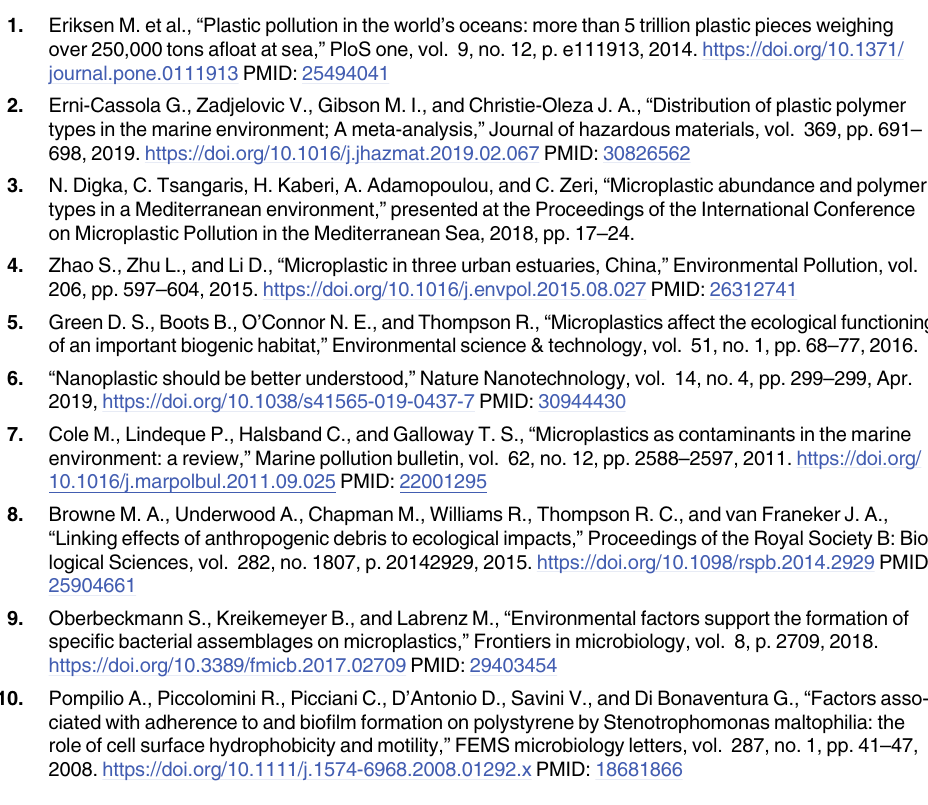
S1 Fig. RT-PCR amplification curves for esterase genes after exposure to polyethylene nanoparticles and